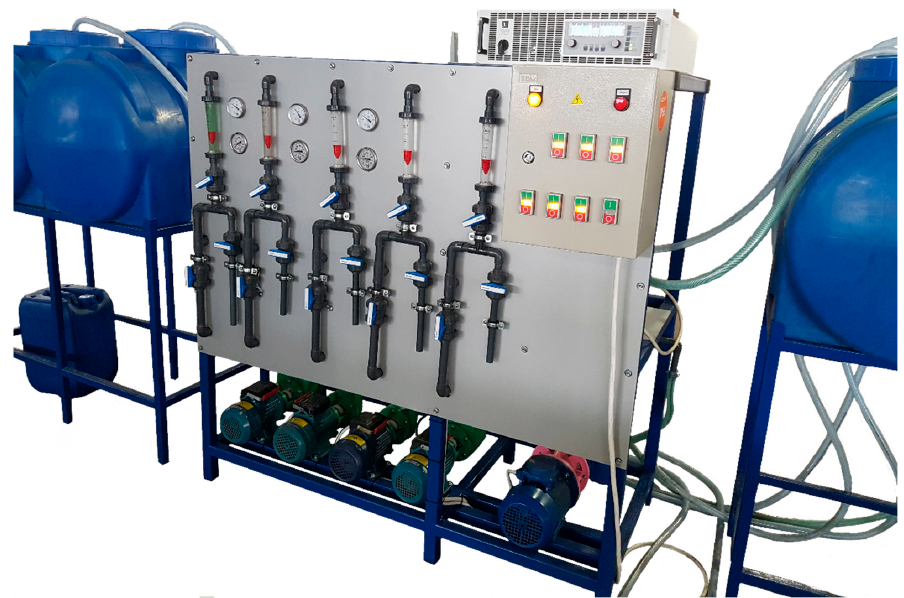
Figure A1. The photo of the filtration module.